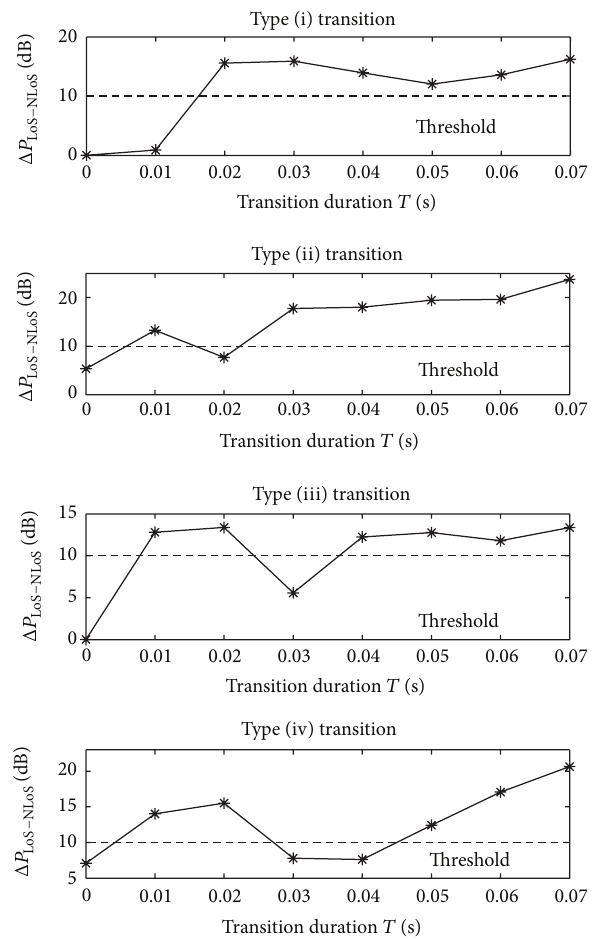
Figure 16: Examples of the four types of transition